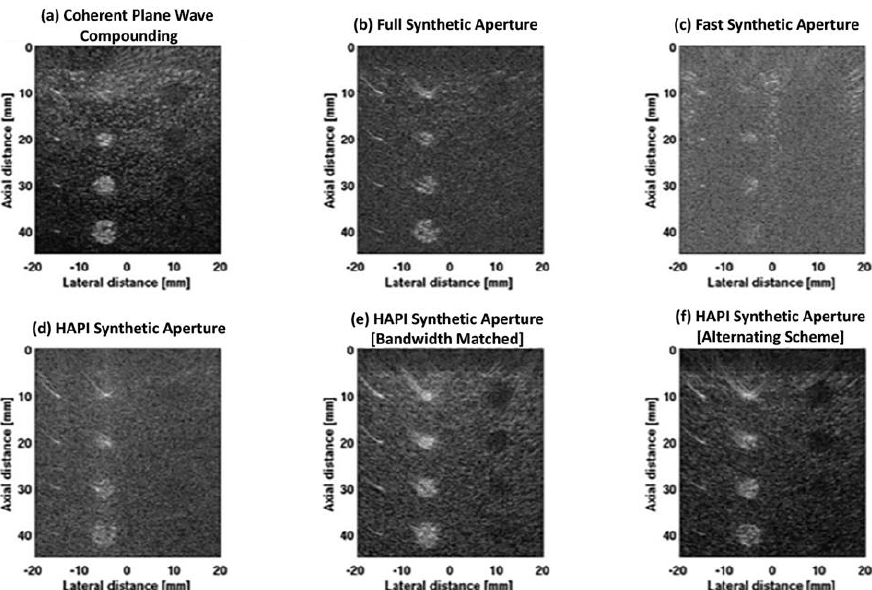
Figure 5. Simulation images of the phantom with 4 hypoechoic cysts and 4 high scattering regions placed at decreasing depths (10 mm, 20 mm, 30 mm, 40 mm) for ( a ) coherent plane wave compounding with 7 angles equally spaced between − 18 ◦ and 18 ◦ , ( b ) traditional synthetic aperture imaging with 128 transmit events, ( c ) fast synthetic aperture imaging with 3 sub-apertures, ( d ) HAPI synthetic aperture imaging with 1 transmit event but no bandwidth matching, ( e ) HAPI synthetic aperture imaging with bandwidth matching, and ( f ) HAPI synthetic aperture imaging with an alternating transmit scheme. HAPI-SA with bandwidth matching ( e ) produces the best images of all the above. The alternating transmit scheme ( f ) of transmitting on every other element and receiving on the rest produces an image better than traditional SA ( a ) but worse than the full HAPI-SA ( e ). When the bandwidth is not matched, the quality of the image suffers ( d ). All images are shown at a 55 dB dynamic range. Table 2. Comparison of SNR, CNR, and CSR for imaging methods.